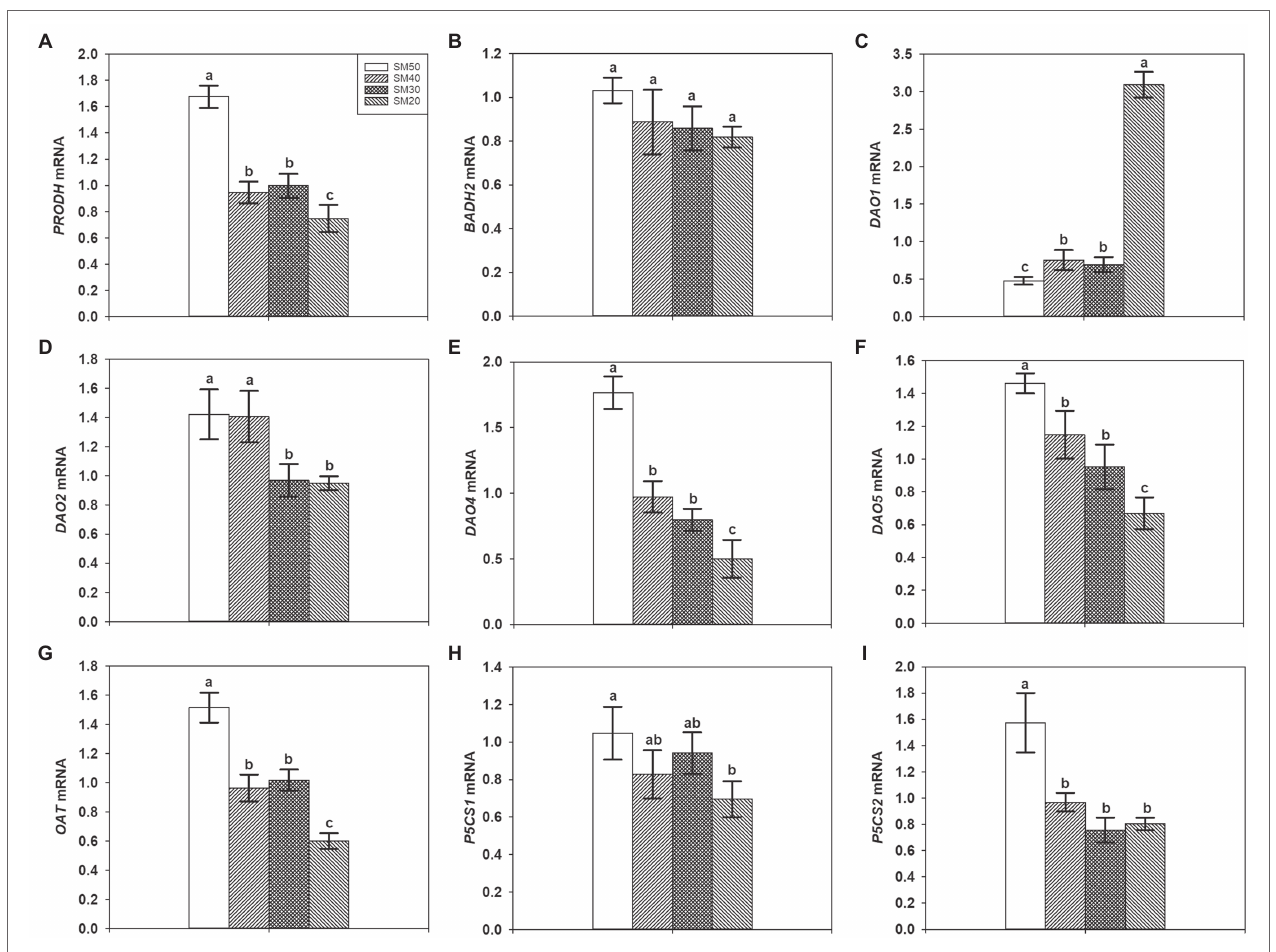
FIGURE 4 | Effects of different soil moisture contents on expression levels of PRODH (A) , BADH2 (B) , DAO1 (C) , DAO2 (D) , DAO4 (E) , DAO5 (F) , OAT (G) , P5CS1 (H) , and P5CS2 (I) in fragrant rice. Each column represents the mean of three data ± standard error ( n = 3). Bars sharing a common letter do not differ significantly at ( p <